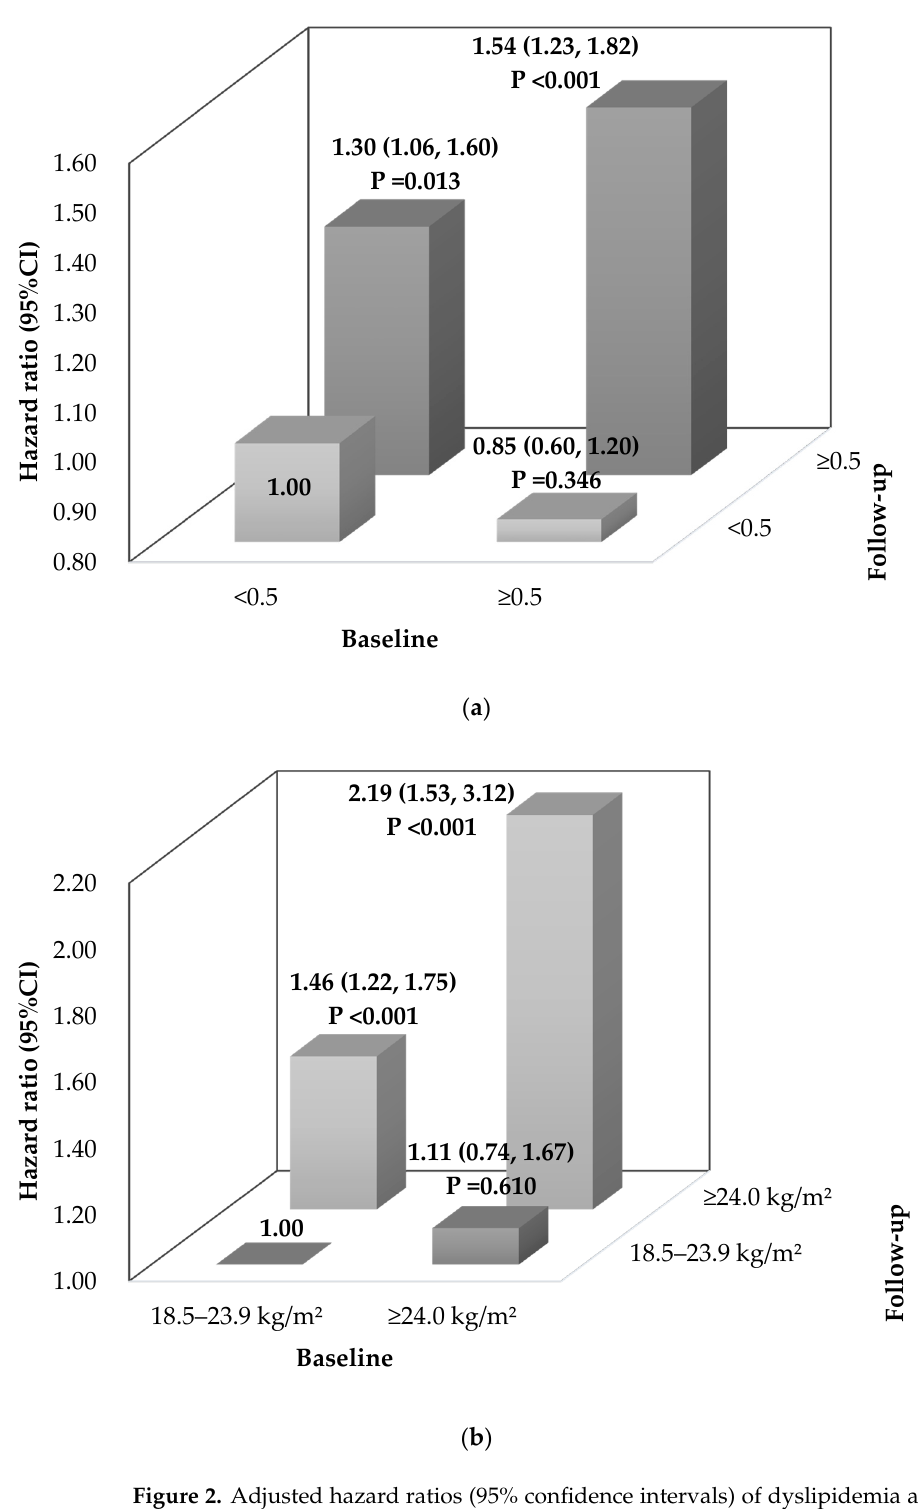
Figure 2. Adjusted hazard ratios (95% confidence intervals) of dyslipidemia associated with joint classification of WHtR and BMI categories from baseline to follow-up. ( a ) Joint classification of WHtR categories from baseline to follow-up; ( b ) Joint classification of BMI categories from baseline to follow-up. Note: Adjusted for age (categorical variable), sex, residence, nationality, current alcohol drinking, regular physical exercise, baseline WHtR categories (only for joint classification of WHtR categories), and baseline BMI categories (only for joint classification of BMI categories).